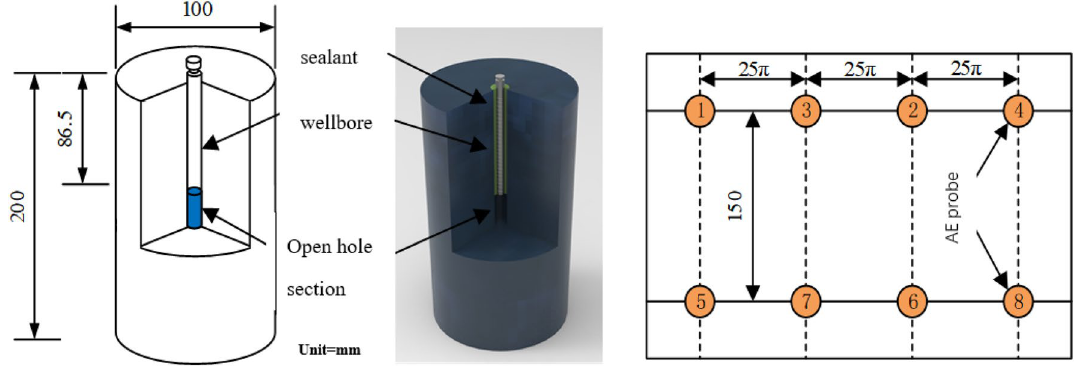
Fig. 12 Location diagram of fracturing sample and acoustic emission